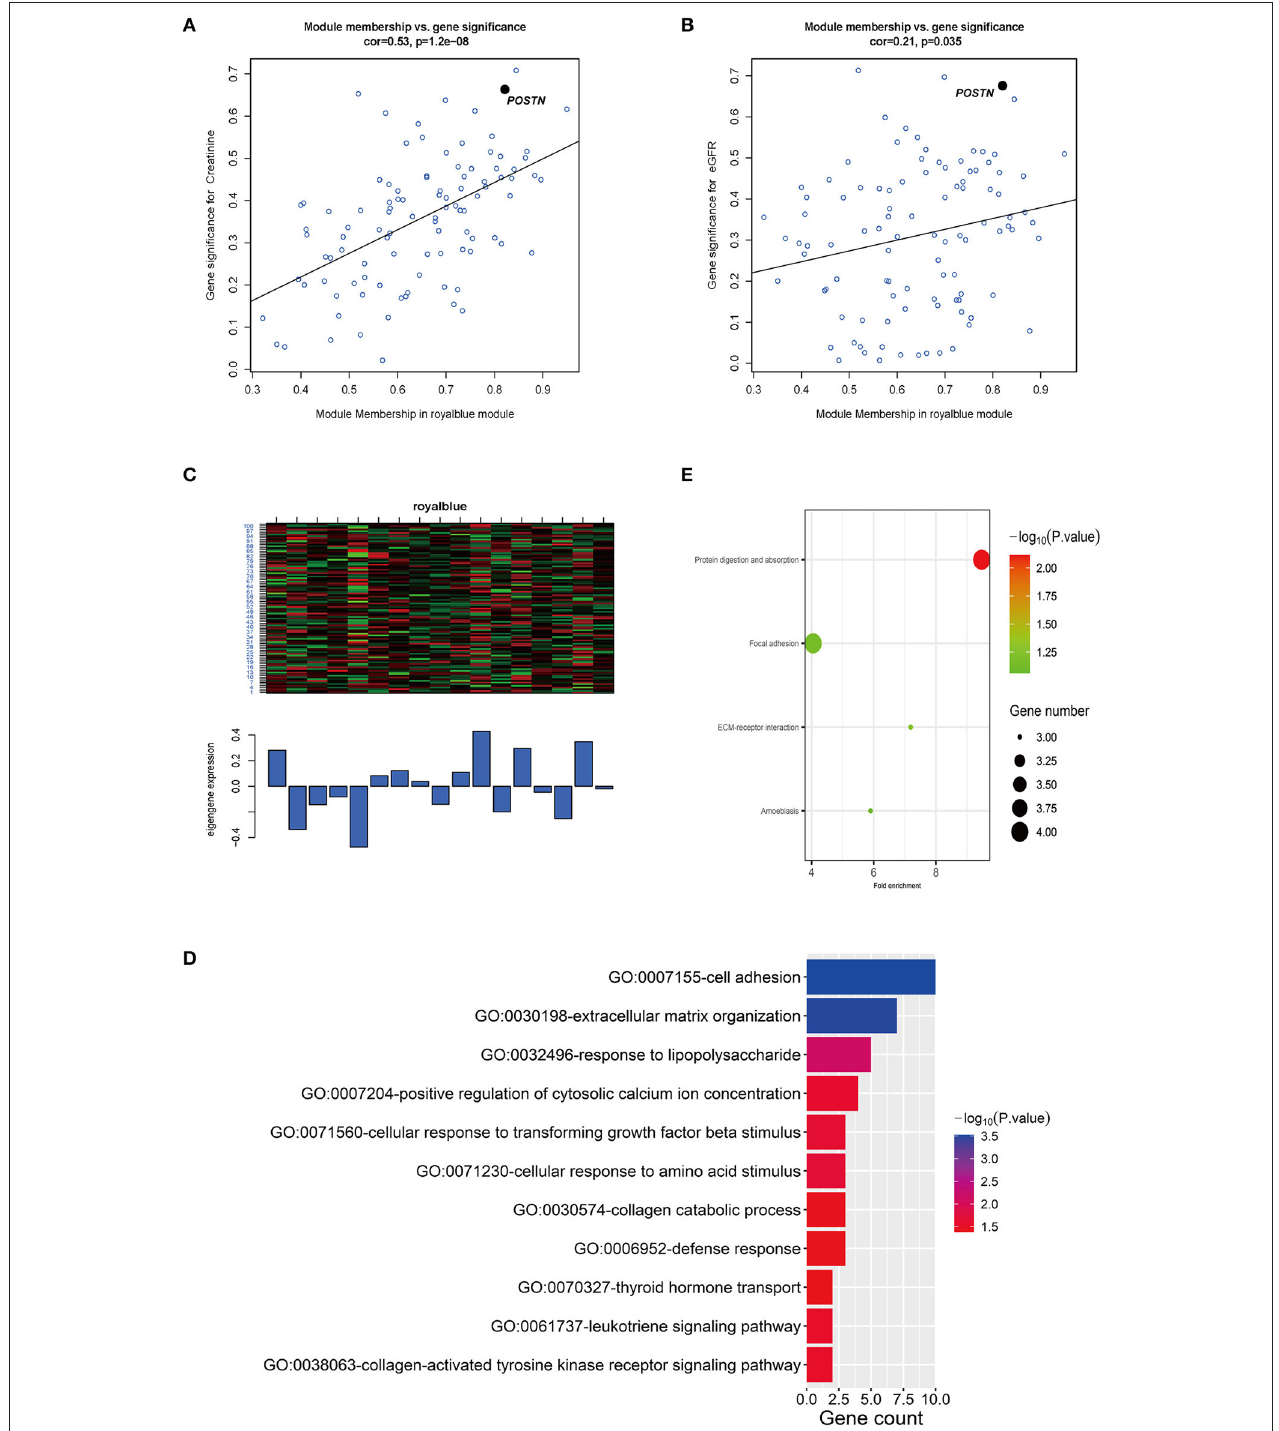
FIGURE 5 | Relationship between key modules and clinical features and GO analysis of genes in the key module. (A,B) Scatterplots of GS vs. MM in the royalblue module with creatinine and eGFR of IgAN patients. The correlation between GS and creatinine and eGFR was 0.53 ( P = 1.2e − 08) and 0.21 ( P = 0.035), respectively. POSTN had the highest MM and GS for creatinine (MM = 0.82 and GS = 0.66) and eGFR (MM = 0.82 and GS = − 0.67) of all genes in the royalblue module. (C) Heatmap and bar graph of gene expression distribution of 101 genes in the royalblue module. (D) GO analysis of genes in the royalblue module, with threshold count ≥ 2 and P < 0.05. (E) Only one KEGG pathway (protein digestion and absorption) was enriched for the royalblue module; three additional pathways (ECM–receptor interaction, focal adhesion, and amoebiasis) are shown.